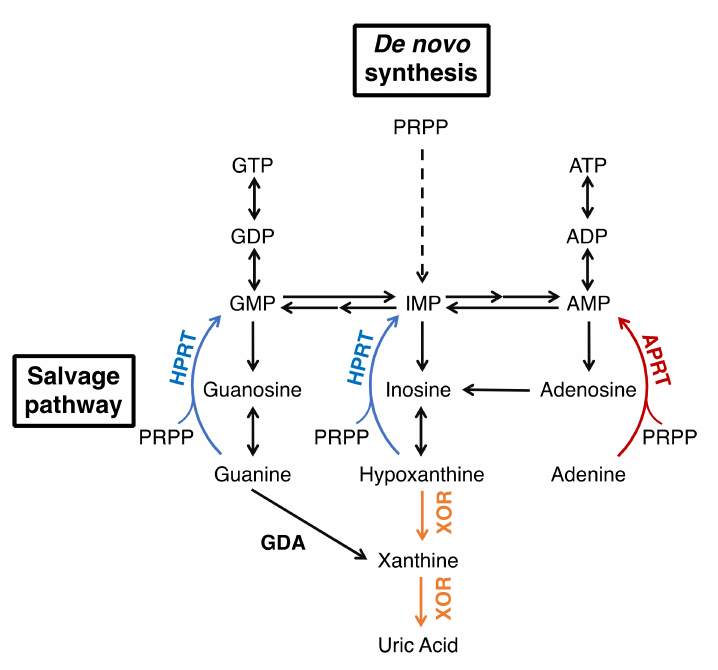
Figure 1. Purine